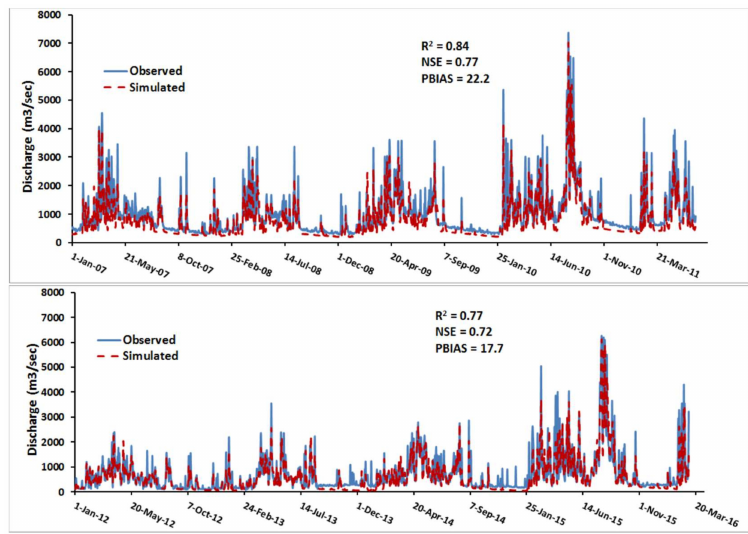
Figure 4. Daily observed versus simulated Kabul river discharge for calibration period (2007–2011, top Figure) and validation period (2012–2015, bottom Figure). X -axis shows the time period (years) of observed and simulated discharge, while the Y -axis presents the daily discharge measured in cubic meter per second (m 3 s − 1 ). The blue line showed daily observed flow and dotted red line showed modelled (simulated) discharge for Kabul River.